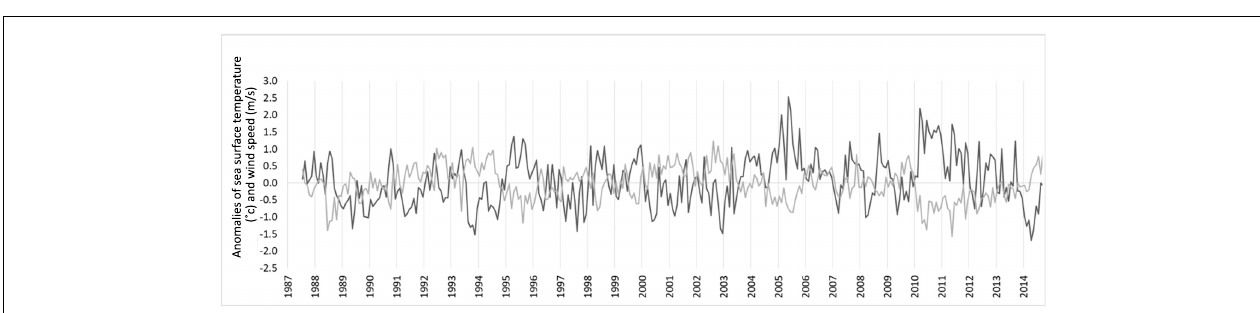
FIGURE 3 | Sardinella aurita annual landings in Venezuela (source: FAO).